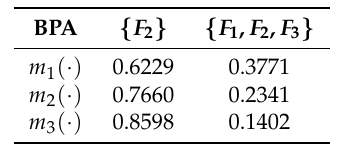
Table 8. The collected sensor reports at the frequency of 2 X modeled as BPAs.